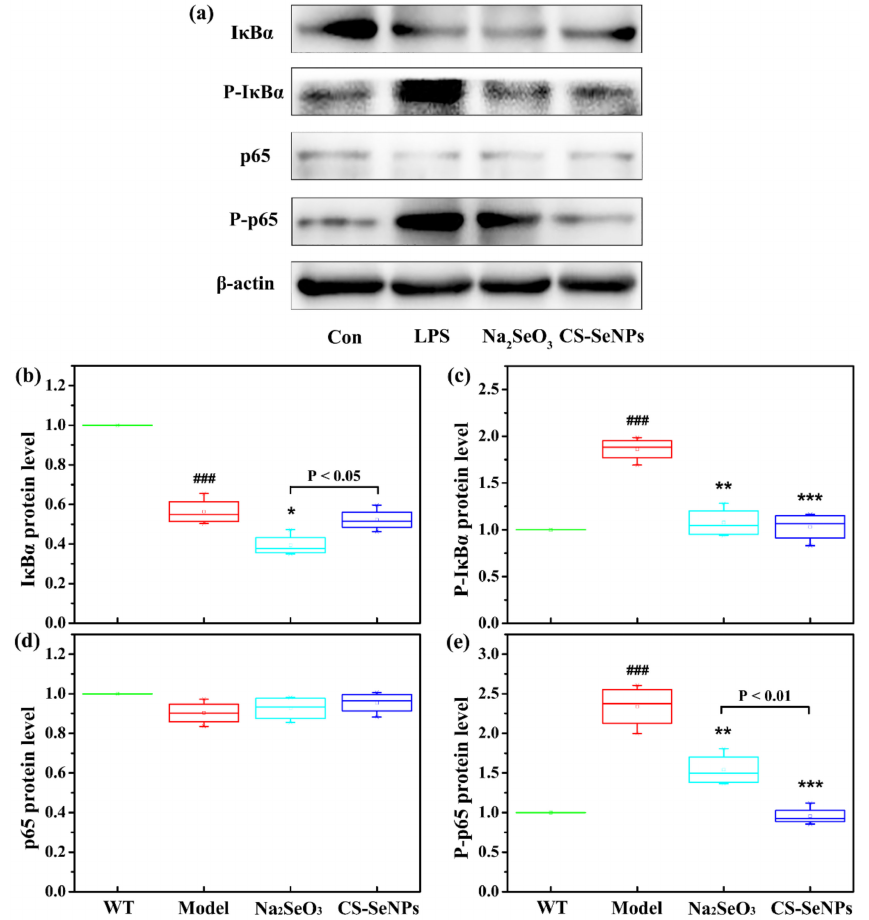
Figure 10. CS-SeNPs and Na 2 SeO 3 suppressed LPS-induced activation of NF- κ B signaling pathway in ECs. After pretreatment with or without 0.5 µ M CS-SeNPs or Na 2 SeO 3 for 12 h, cells were stimulated with LPS for another 12 h. Western blot analysis was done to determine the protein levels of I κ B α , phosphorylated I κ B α (P-I κ B α ), p65, phosphorylated p65 (Ser 536) (P-p65) and β -actin. ( a ) Representative Western blot bands. ( b – e ) Quantification analysis of I κ B α ( b ), P-I κ B α ( c ), p65 ( d ) and P-p65 ( e ) normalized to β -actin. The results were expressed as mean ± SD ( n = 4). ### p < 0.001, compared with the control cells (Con). * p < 0.05, ** p < 0.01, *** p < 0.001, compared with cells treated with LPS